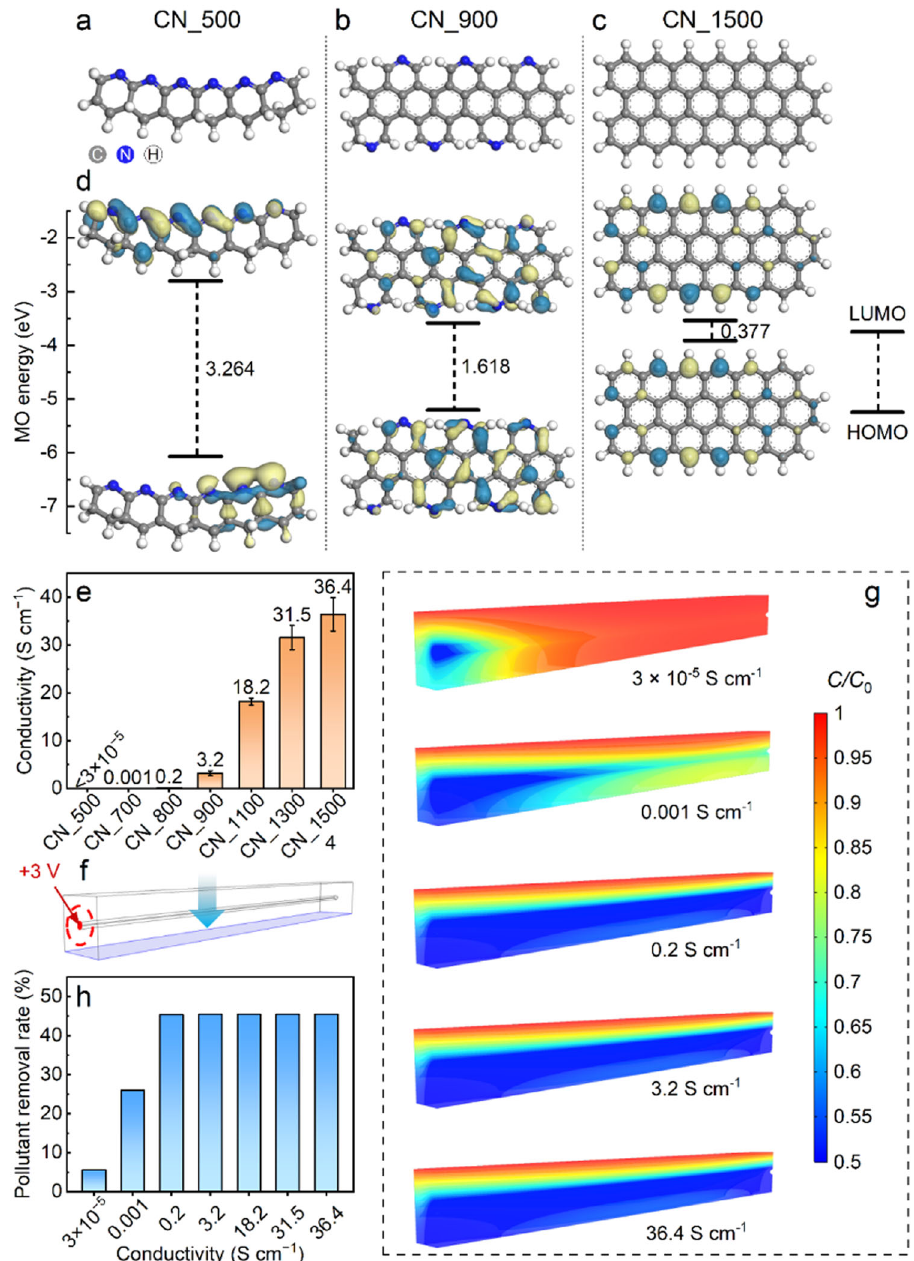
Fig. 4 | Quantum and multiphysics simulations of electrocatalytic perfor- mance. Optimized stable molecular structures, representing the a CN_500, b CN_900, and c CN_1500. d Optimized frontier molecular orbitals and LUMO – HOMO energy gaps for the CN_500, CN_900, and CN_1500. e Comparison of the measured conductivities among the different CNs. f Established model for multiphysicsanalysessimulatingapollutantsolution fl owingthroughachargedCN segment. g Computed distributions of the normalized pollutant concentration